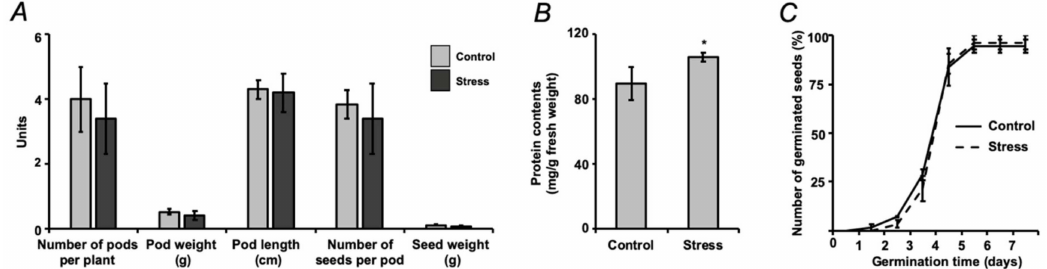
Figure 4. Characterization of pea ( Pisum sativum L., cultivar SGE) seed quality, assessed after a two-day exposure to the aqueous medium with and without supplementation of 2.5% ( w / v ) PEG 8000 (defined as stress and control, respectively) during seed maturation: pod and seed metrics ( A ), protein contents ( B ) and germination rate ( C ); * denote statistical significance ( t -test) at the confidence level p <